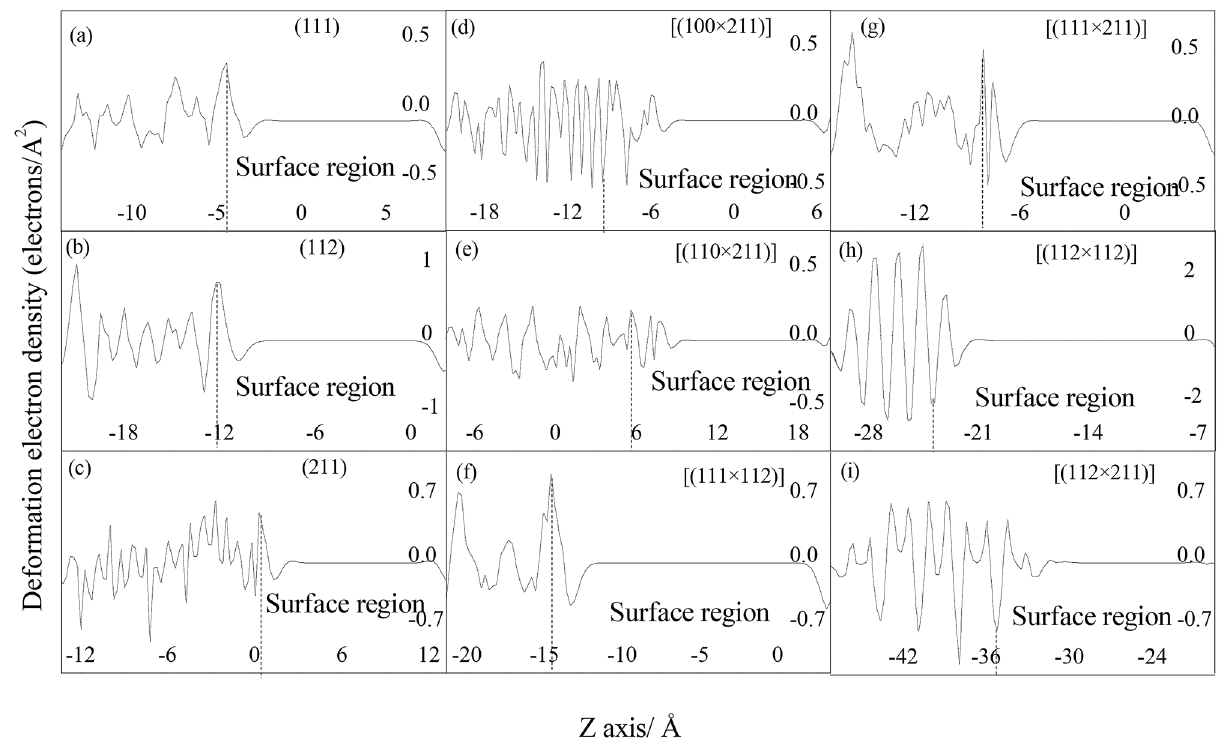
Figure 4. Deformation electron density of MnO 2 bulk surface and microfacet models along Z